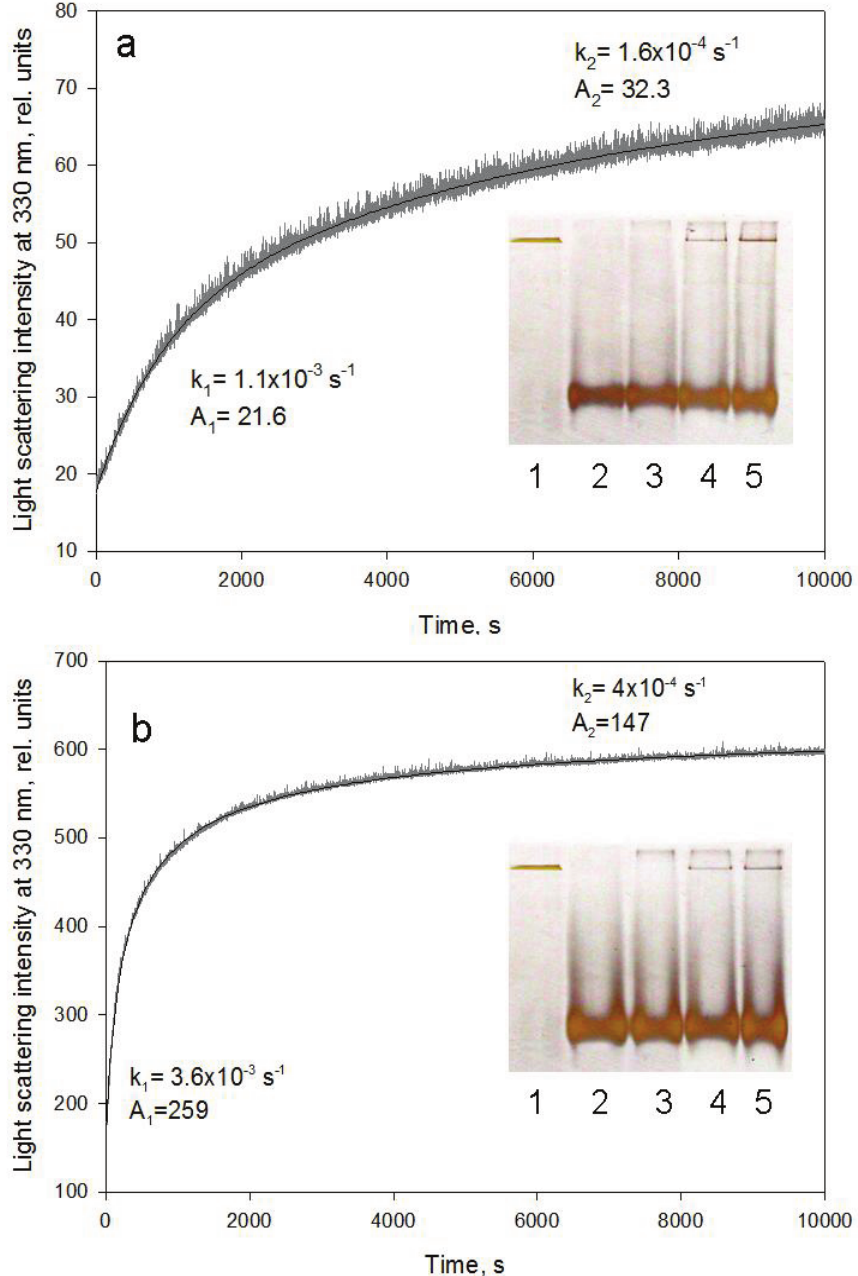
Figure 5. GroEL reassembly kinetics monitored by light scattering at 330 nm. ( a ) in 20 mM , 20% glycerol, 0.4 M urea; ( b ) in 20 mM Tris-HCl, pH 7.5, 5 mM β ME, 10 mM MgCl 2 ) SO , 1 mM MgCl , 0.5 mM ATP, 0.4 M urea. Tris-HCl, pH 7.5, 5 mM β ME, 50 mM (NH 4 2 4 2 Rate constants and amplitudes of the protein oligomerization kinetic phases are shown at corresponding parts of the kinetics. Inserts represent nondenaturing electrophoresis of the products after termination of the oligomerization reaction by 10-fold dilution of the reaction mixture components at various time intervals (slots: 1 — full-size GroEL ; 14 2 — folded monomer GroEL ; 3 – 500 s; 4 – 2700 s; 5 – 5400 s after oligomerization start). 1 The staining of the gels was performed using